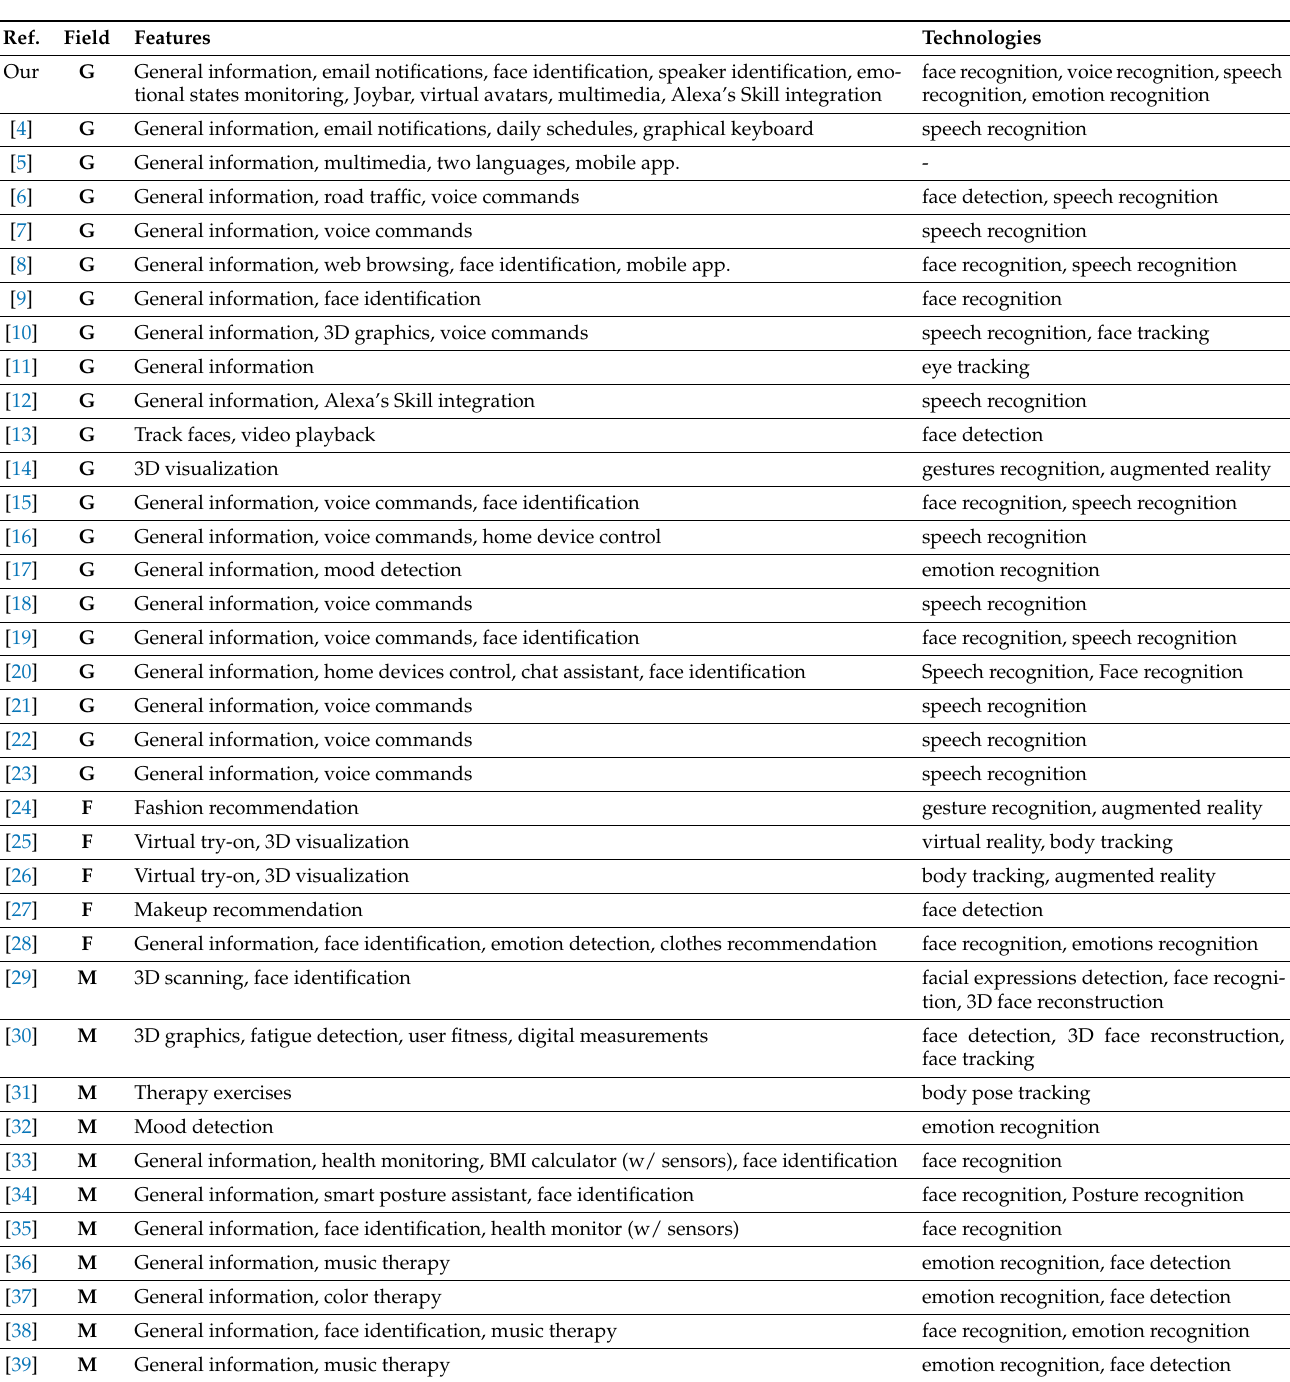
Table 1. A summary table of main features and technologies of smart mirror prototypes in literature. Field indicates intended use of mirror: (G)eneral, (M)edical, and (F)ashion. Ref. Field